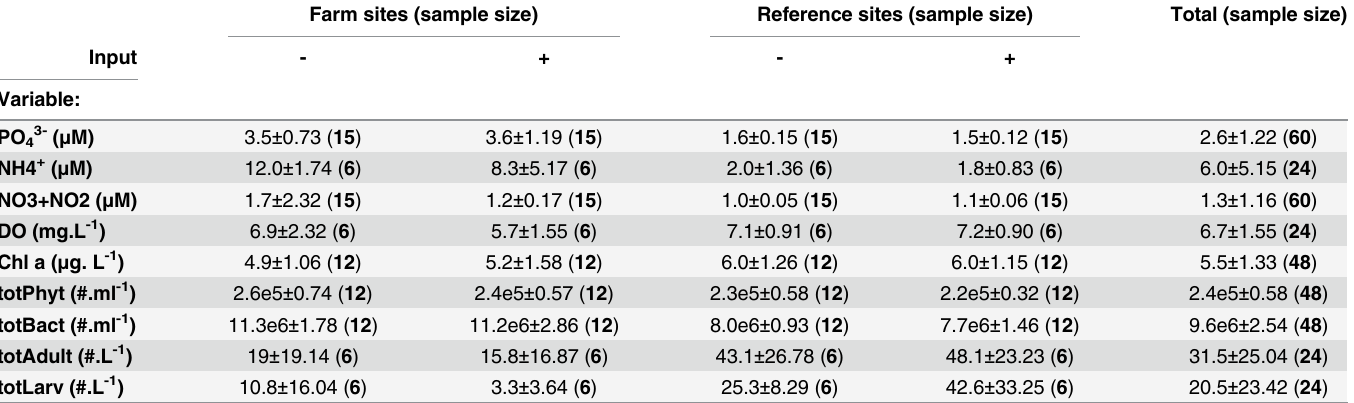
Table 1. Mean values ± SD (sample size) for all the variables measured in the mesocosms during the experiment. Farm sites (sample